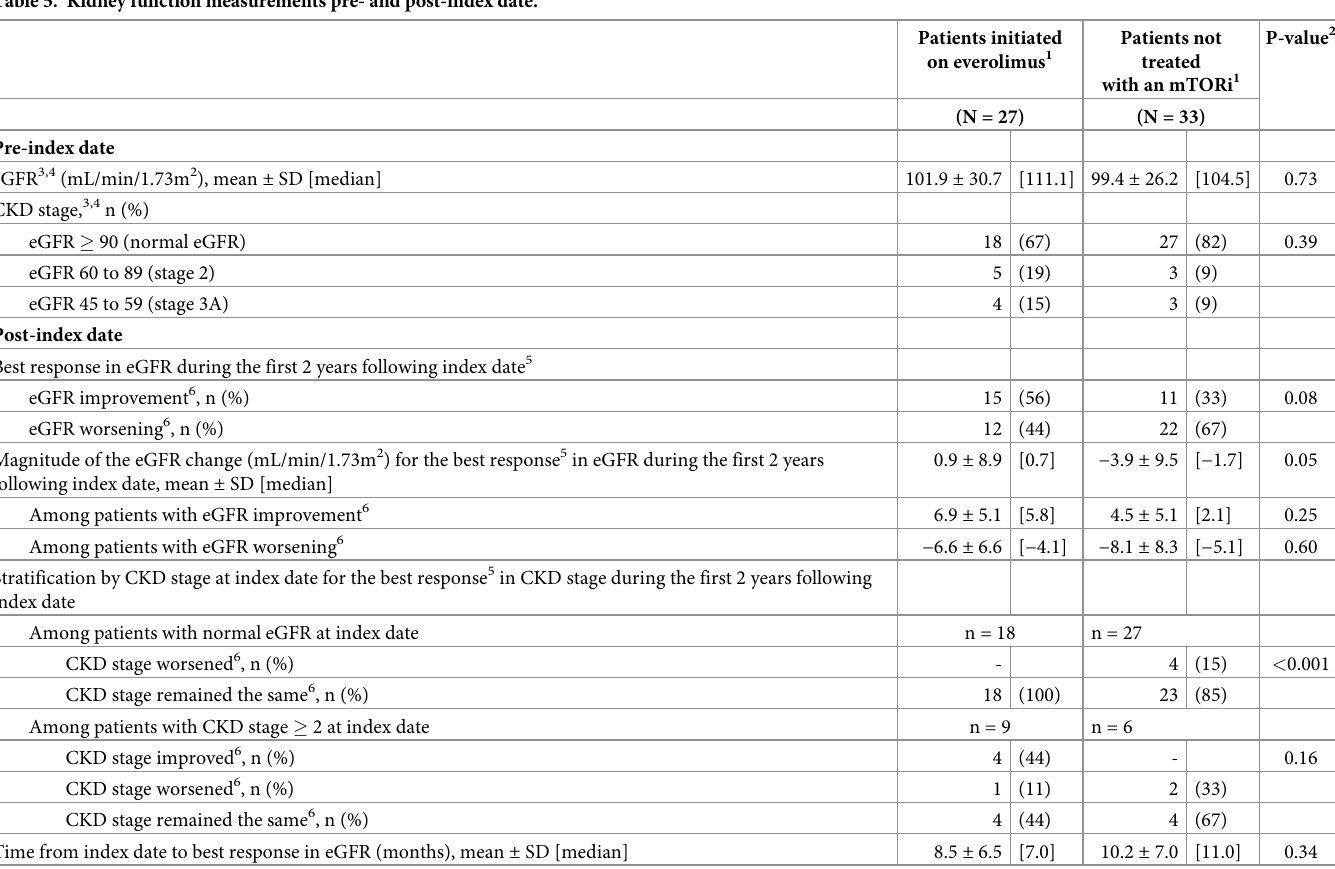
Table 5. Kidney function measurements pre- and post-index